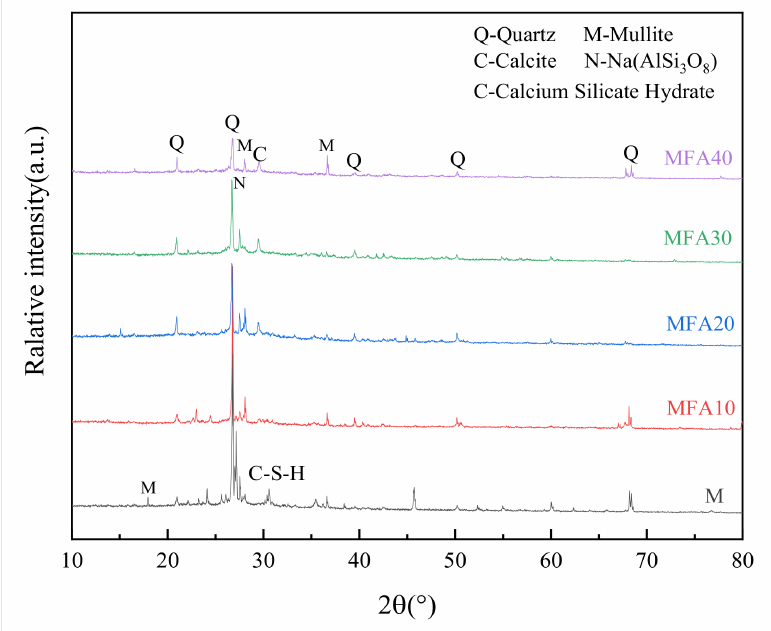
Figure 14. XRD patterns of MFA-GPC